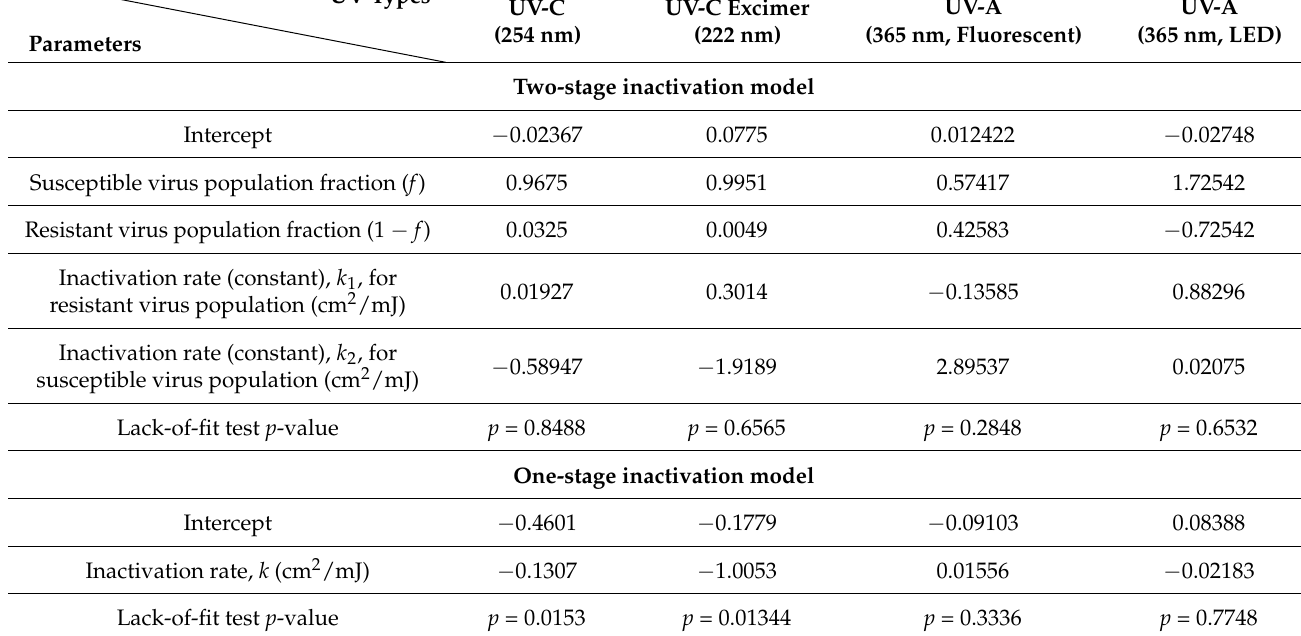
Table 2 shows the parameters (including inactivation rate, k ) of the one-stage and two- stage models derived from the experimental data. The raw experimental data was organized into a spreadsheet (UV dose vs. PRRSV titer.xlsx) included in Supplementary Materials. Table 2. One-stage and two-stage models, parameter estimations, and model parameters for inactivation of airborne PRRSV with four types of UV light tested.